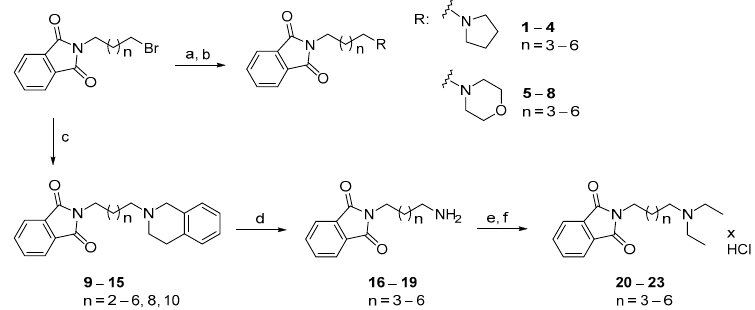
Figure 1. The general structures of the designed